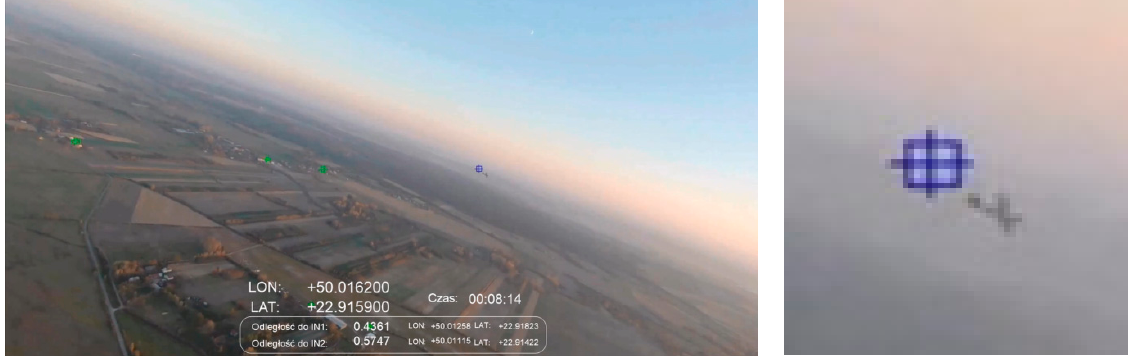
Figure 9. Scenario related to Figure 5C; evening, sun ~90 degrees to the right, altitude ~200 m; distance to intruder: 436 m.